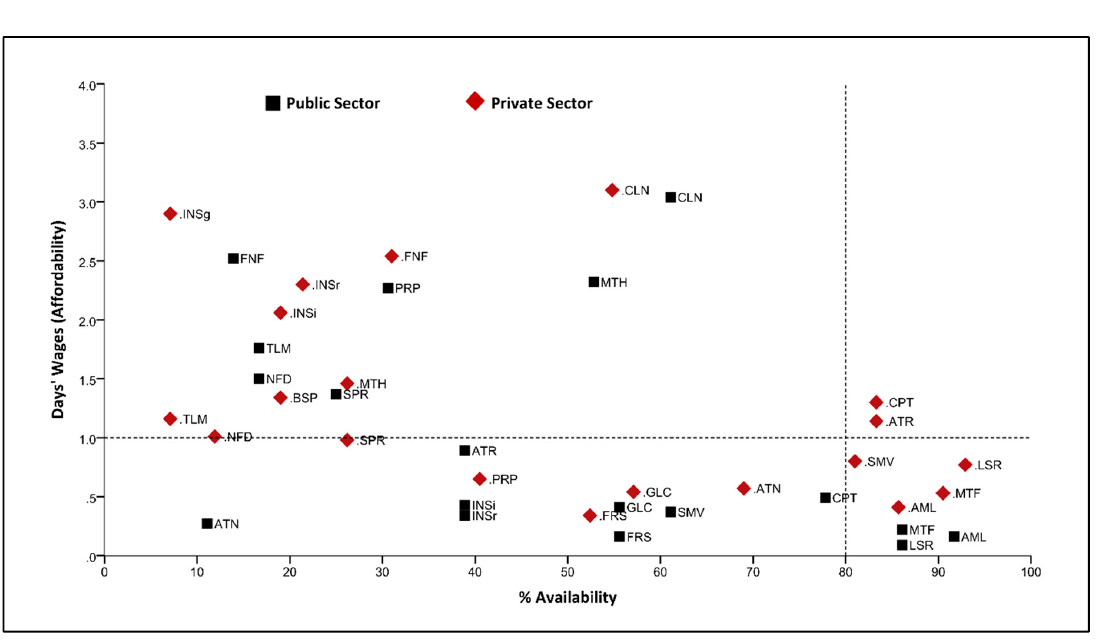
Figure 2. Comprehensive analysis of LPGs’ availability and affordability in public and private sector. AML, amlodipine; ATN, atenolol; ATR, atorvastatin; BSP, bisoprolol; CLN, clonidine; CPT, captopril; FNF, fenofibrate; FRS, furosemide; GLC, gliclazide; INSg, insulin glargine; INSi, insulin human isophane; INSr, insulin human regular; LSR, losartan; MTH, methyldopa; MTF, metformin; NFD, nifedipine; PRP, propranolol; SMV, simvastatin; SPR, spironolactone; TLM, telmisartan.